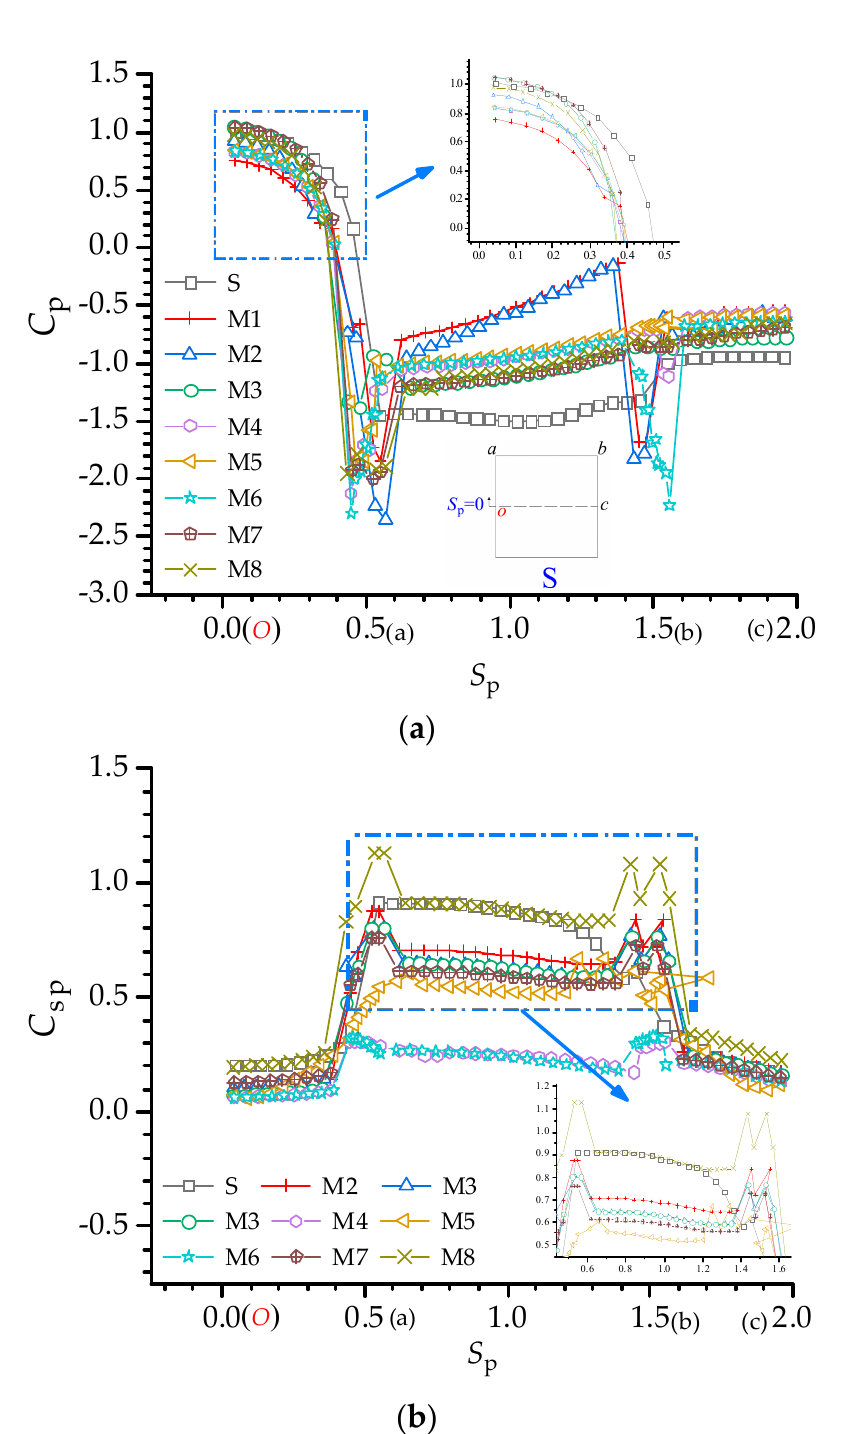
Figure 10. Wind pressure coefficients distributions of the benchmark section S and optimal sections M1~M8: ( a ) C p and ( b ) C σ p .